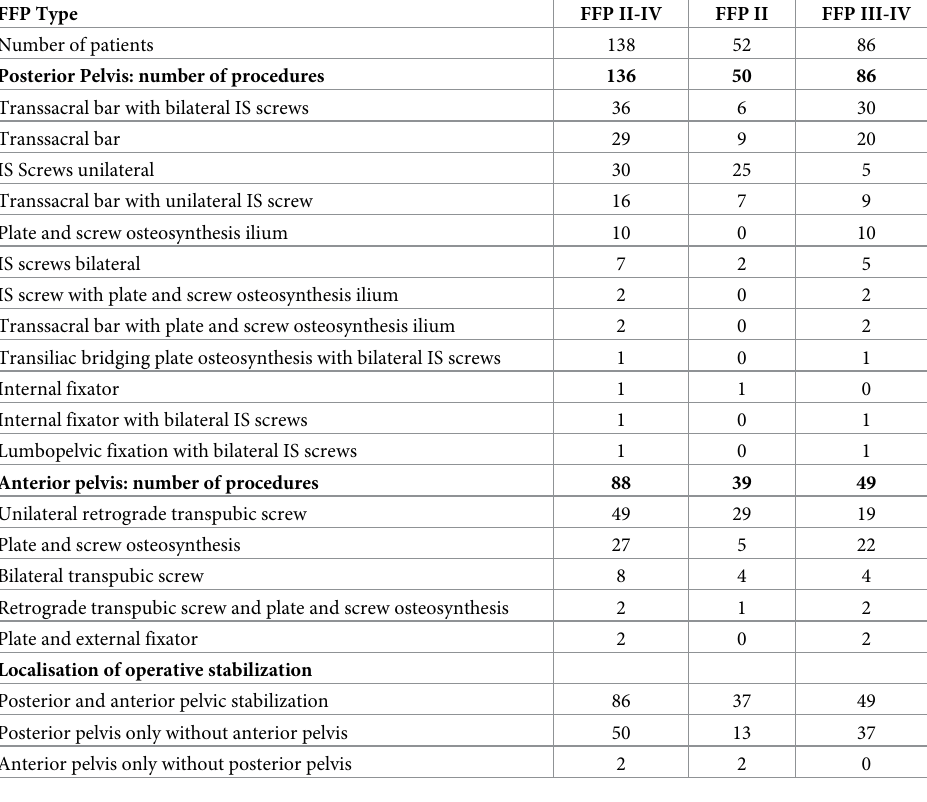
Table 4. Type and number of operative procedures on posterior and anterior pelvis in 138